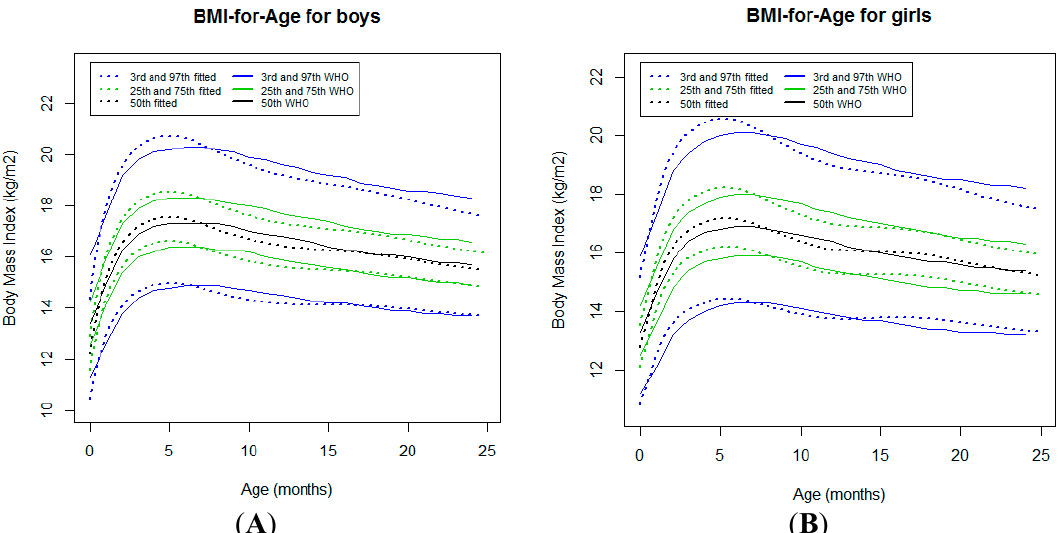
Figure 5. Comparison of the WHO Child Growth Standards (solid lines) with smoothed centile curves (dotted lines) of measured body mass index (BMI) for age for boys ( A ) and girls ( B ) from the neonatal period to 24 months of age.